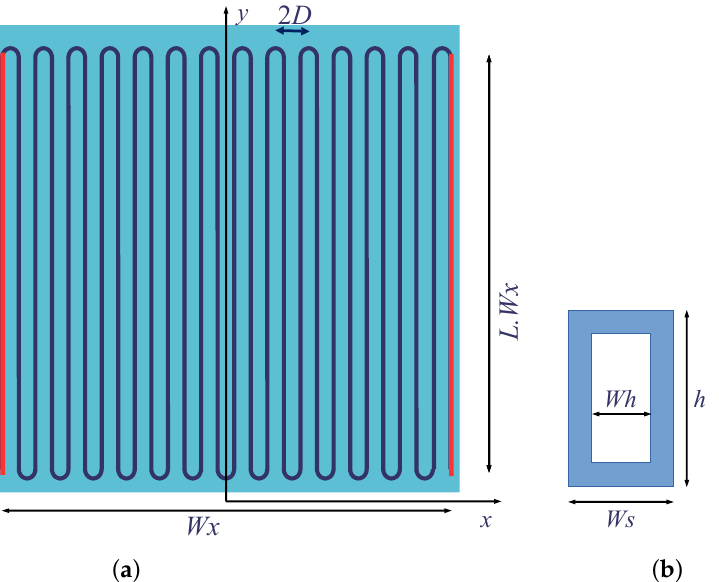
Figure 4. Schematic representation ( a ) of the meander geometry, with J = 28 including the edge segments represented in red; ( b ) of the SQUID geometry (JJs are not represented).